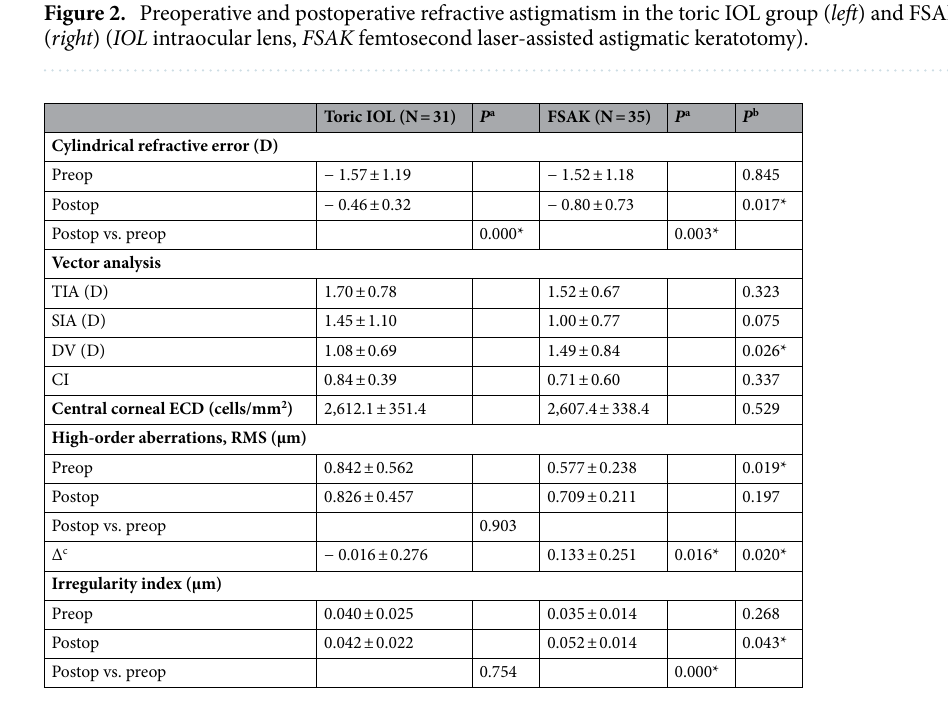
Table 2. Postoperative changes in astigmatism and corneal aberrations. TIA target-induced astigmatism, D diopter, SIA surgically induced astigmatism, DV difference vector, CI correction index, ECD endothelial cell density, RMS root-mean square. a Comparison with baseline, P < 0.05 was considered statistically significant. b Comparison of both groups at each time. c